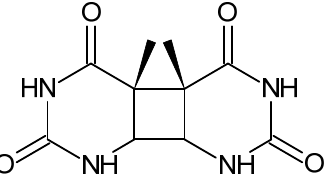
Figure 4. Cyclobutane thymine dimers (thymine dimers).